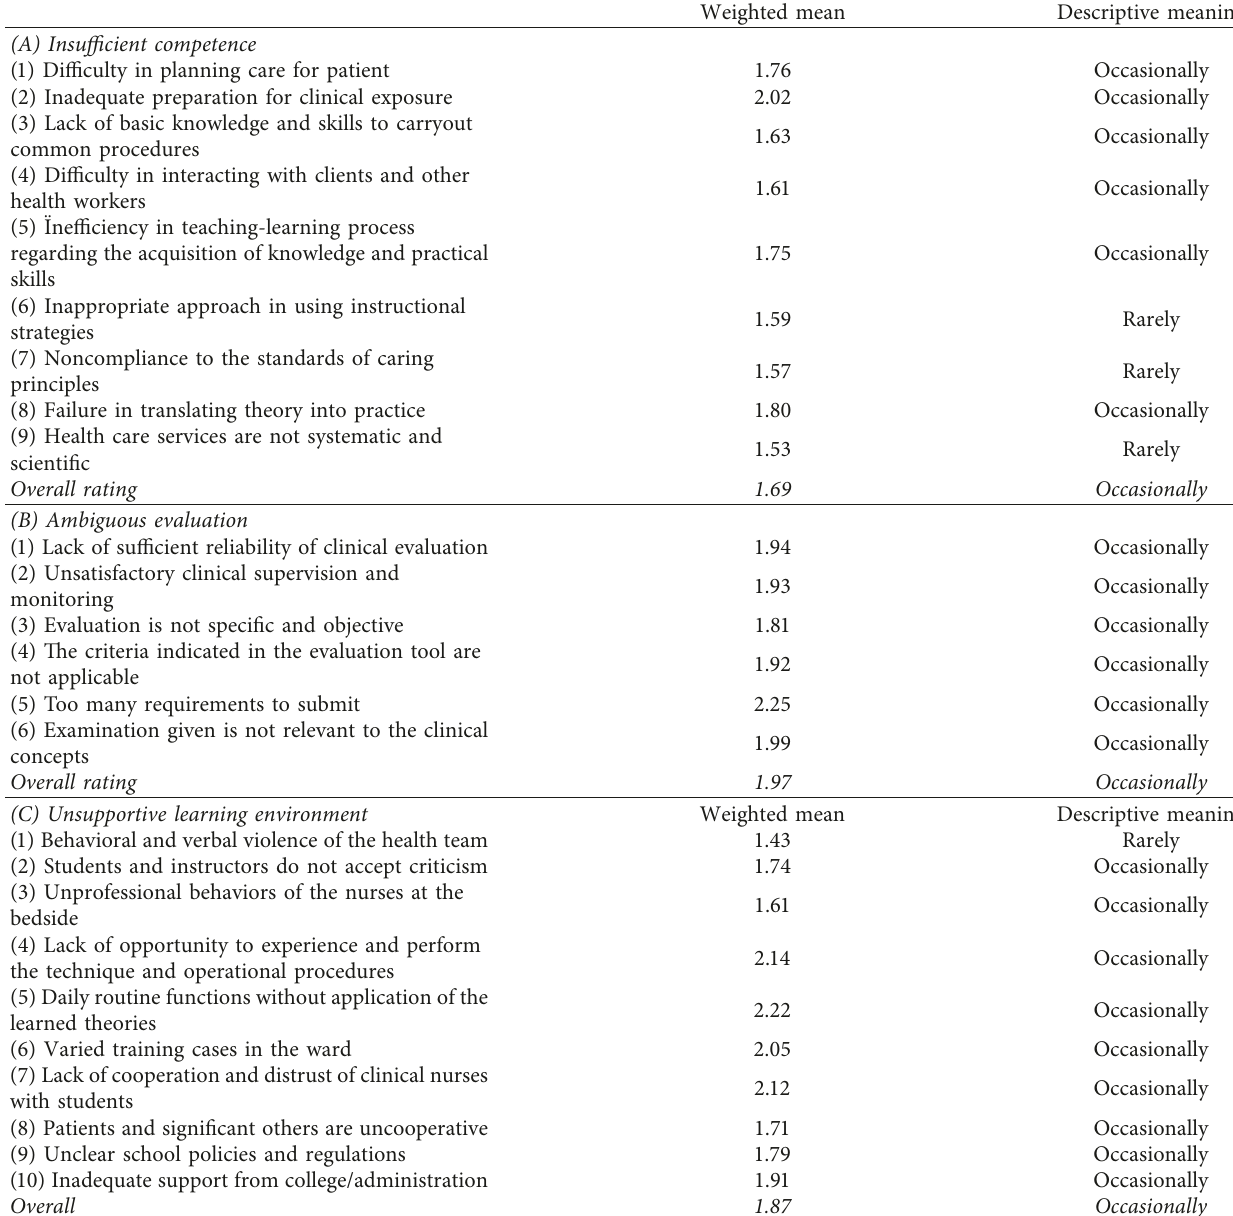
Table 2: Clinical challenges experienced by the Saudi nursing